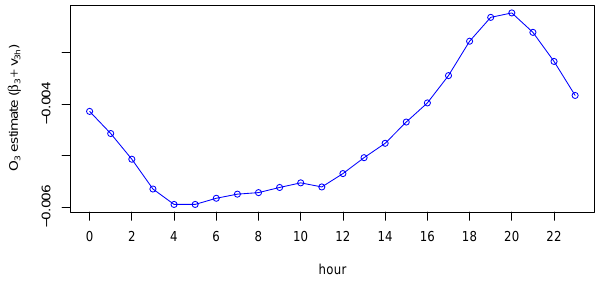
Fig. 3. Variation of the random effect of ozone concentration within a day.